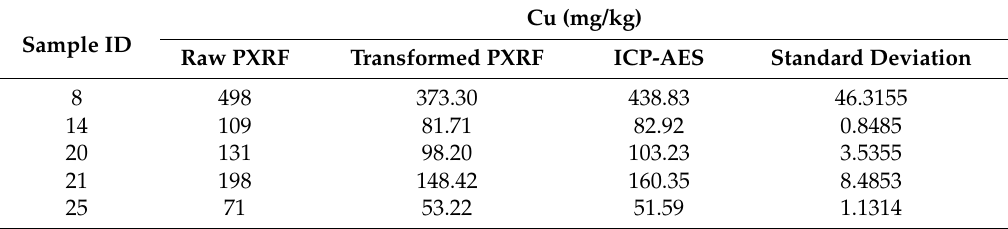
Table 2. Results of elemental analysis for Cu content using an ICP-AES instrument for the validation of transformed PXRF